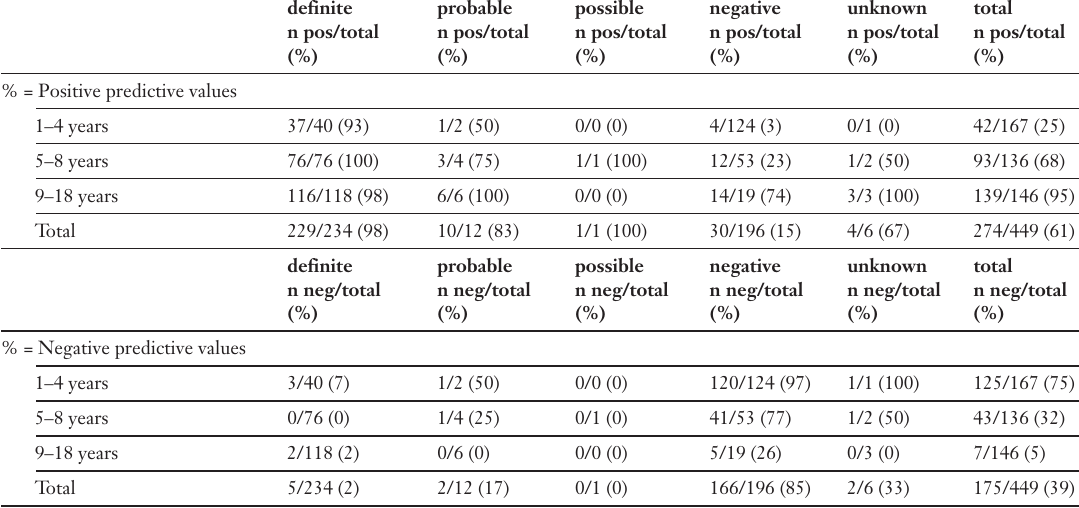
VZV-IgG antibody results* compared to personal history** by age